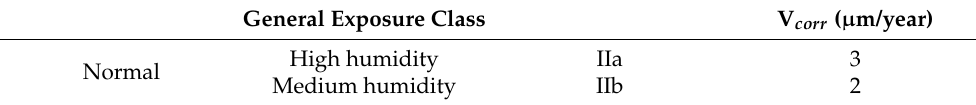
Table 4. Corrosion rate according to general exposure classes.